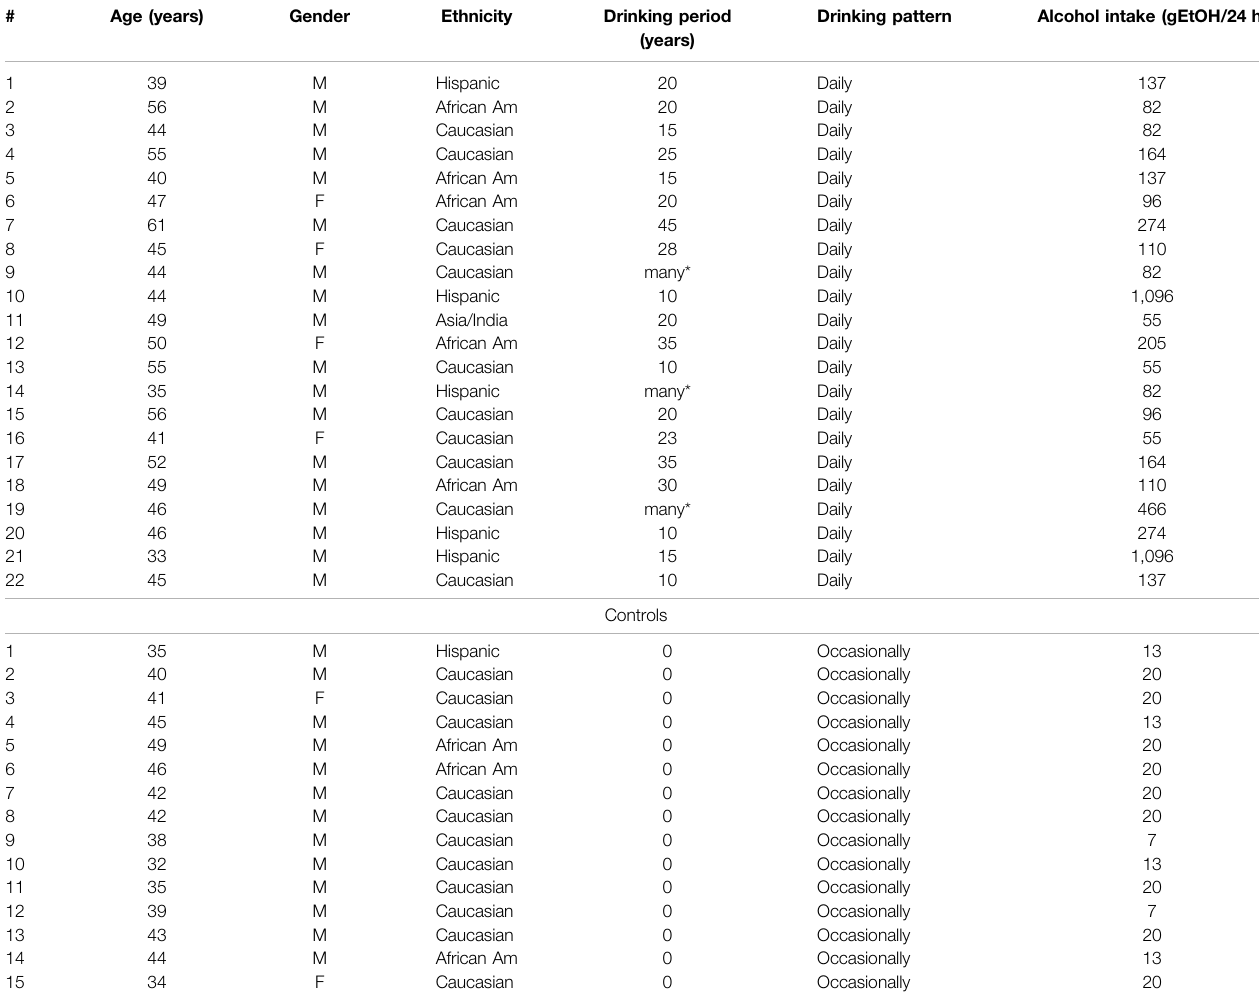
TABLE 1 | Characterization of patients and their drinking behavior. On a few occasions patients did not provide exact number of years drinking (designated by “ many* ” ), however the duration was always more than 10